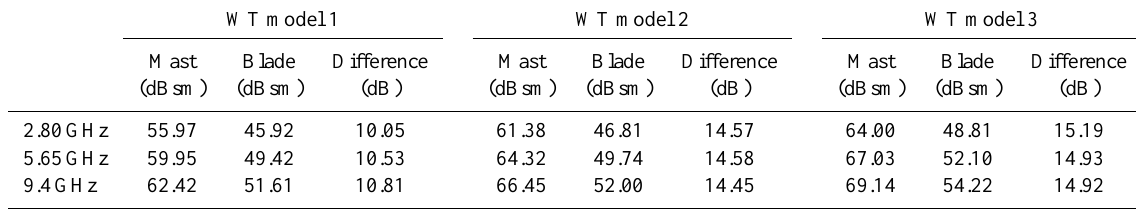
Table 2. Maximum RCS values from the mast and blades for the wind turbine models selected for the simulations.